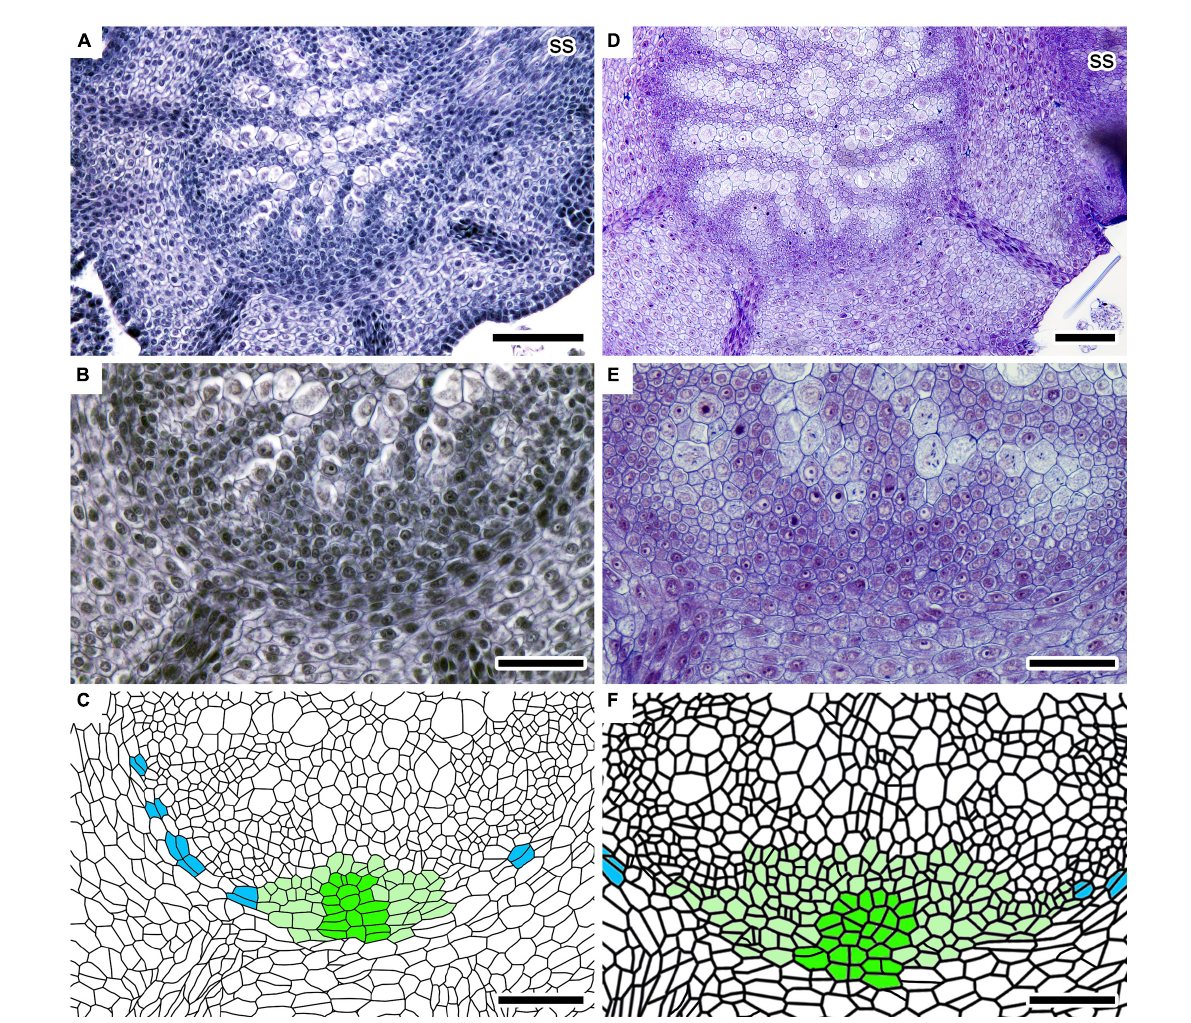
FIGURE4 Root initiation processes in two independent shoots of Lycopodium clavatum . (A–C) In sample #2–35. Cross-sections at 630 µ m from the shoot apex. (B) Close-up of (A) showing root primordium. (C) Line drawing of (B) . A row of initial cells and cell files radiating from it are colored in dark green, while other cells of root primordium in light green. Periclinally divided cells in ground meristem are colored in blue. (D–F) In sample #P3. Cross-sections at 1,268 µ m from the shoot apex. (E) Close-up of (D) showing root primordium. (F) Line drawing of (E) . See (C) for color legend. Scale bars, 100 µ m in (A,D) ; 50 µ m in (B,C,E,F) . ss, small